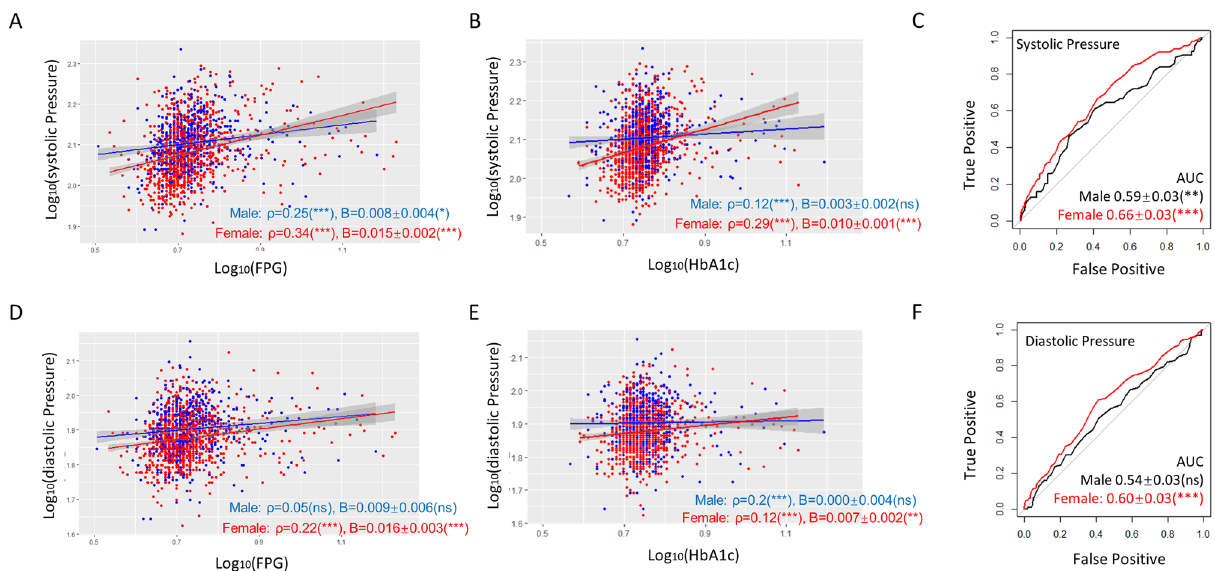
Figure 2. Blood pressure predicts T2D better in women than in men. ( A , B ) Systolic blood pressure has a tighter association (Spearman’s ρ) with and stronger influence (steeper slope) on FPG and HbA1c in women. P values, regression constant can be found in Tables S2 and S3. ( C ) Systolic blood pressure is a stronger T2D predictor for women as judged by ROC-AUC analysis. ( D ) Diastolic blood pressure tends to have a tighter association with FPG and a stronger influence on FPG in women than in men. ( E ) Diastolic blood pressure has a tighter association with HbA1c in men but tends to have a stronger influence on women. ( F ) Diastolic blood pressure is a weak T2D predictor for women and has neglectable prediction power for men. AUC area under the curve, ns not significant, *P < 0.05, **P < 0.01, ***P <